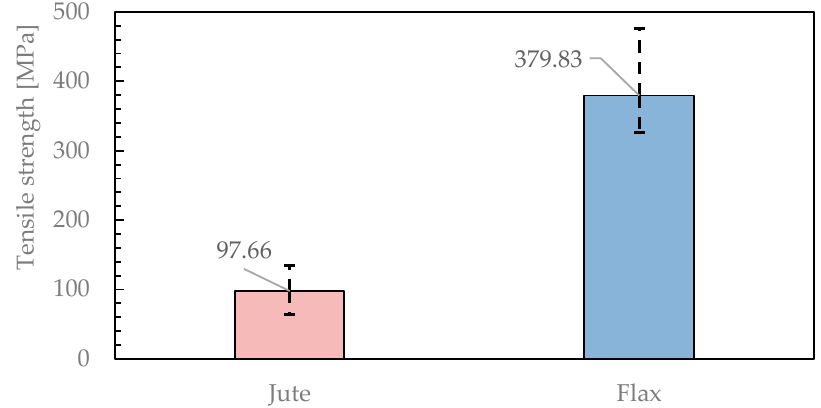
Figure 8. Maximum average tension recorded for flax and jute yarns.